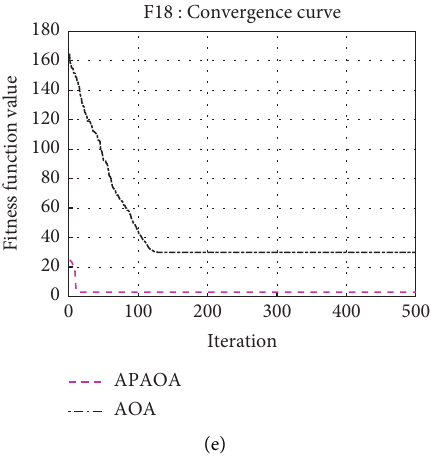
Figure 5: Comparison of convergence curves between APAOA and AOA in F14–F18. Table 7: Parameter settings for algorithms.